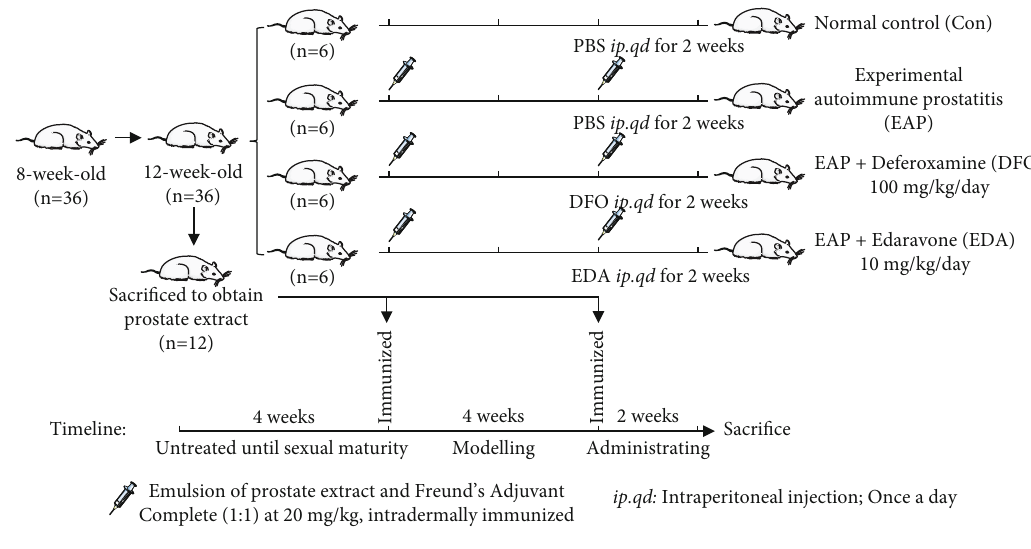
Figure 1: Schematic detailing the process of animal modelling and administrating.